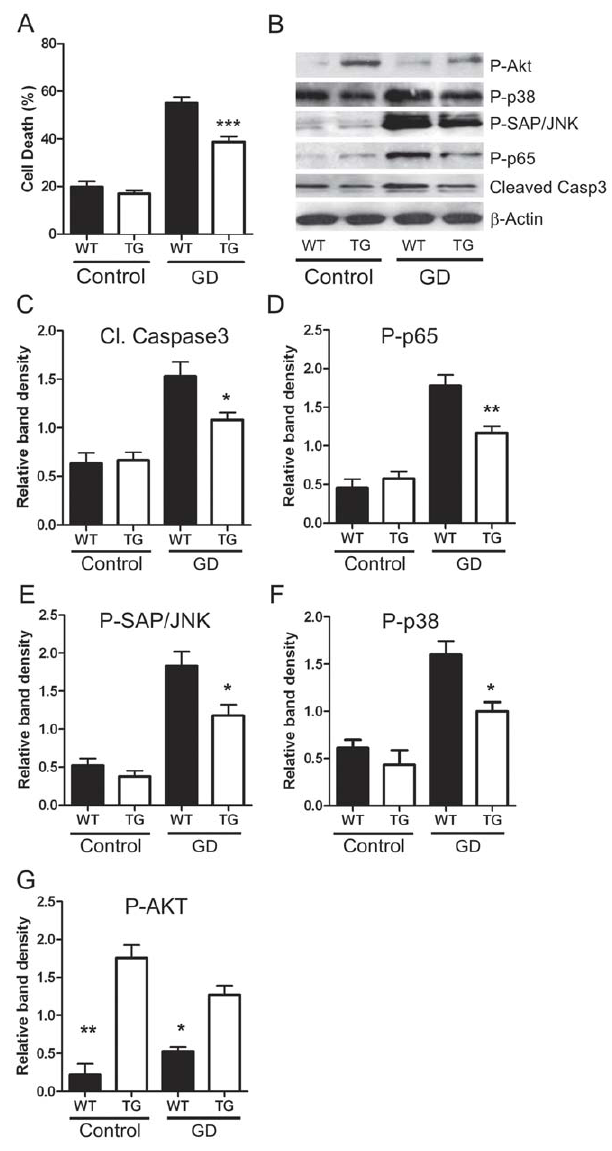
Figure 6. Over-expression of DSCR1 is protective in neurons during glucose deprivation (GD) invitro . DSCR1-TG neurons (white bars) exhibited an improved survival compared with WT (black bars) following 24 h exposure to GD (A). This protection was preceded at 12 h by reduced expression of cleaved caspase-3, P-p65, P-SAP/JNK and P-p38 MAPK (B–F). P-AKT was higher in DSCR1-TG than WT neurons under control conditions and this difference was maintained after GD (B,G). Data are presented as mean 6 SEM; *P , 0.05, **P , 0.01, ***P , 0.001.